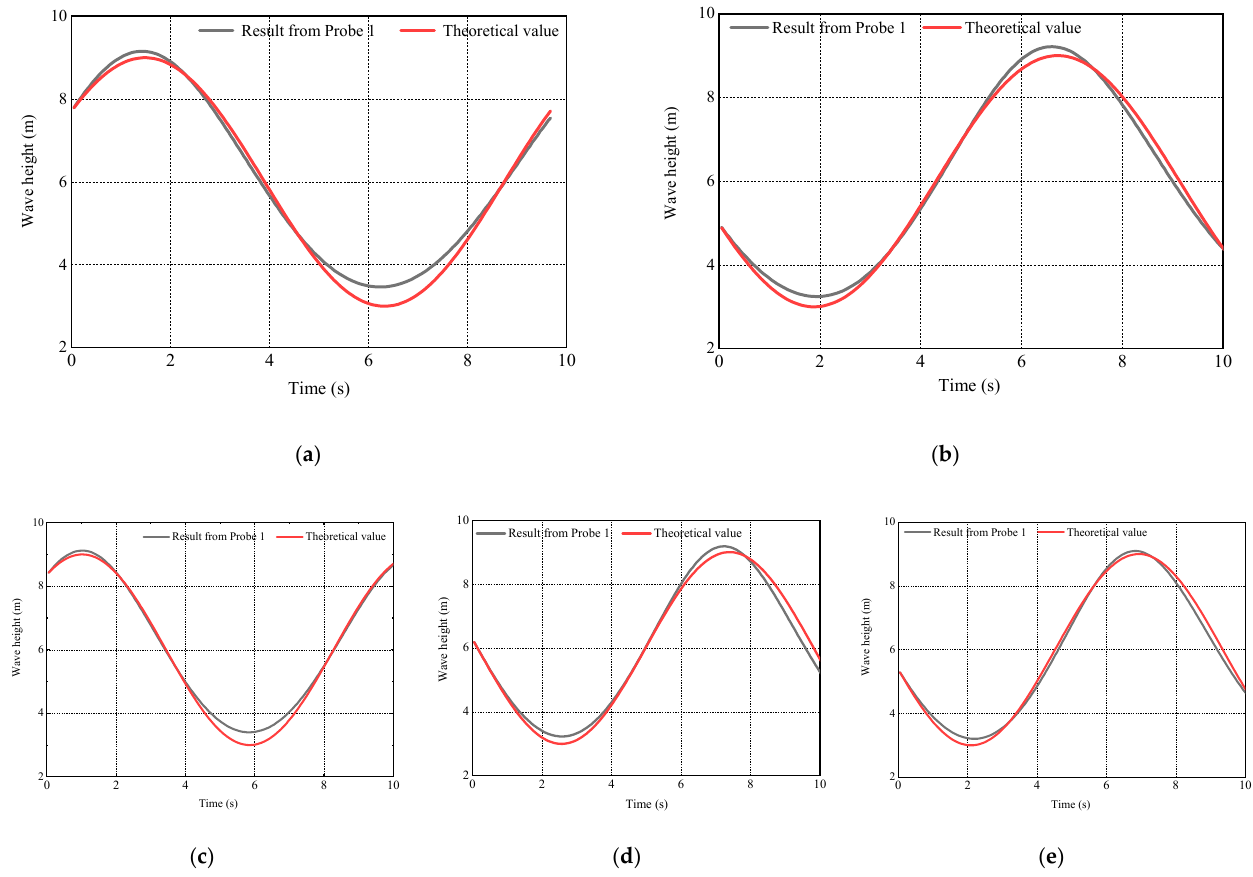
Figure 9. Wave elevation ( λ / L = 1.0). ( a ) θ = 0 ◦ ; ( b ) θ = 15 ◦ ; ( c ) θ = 30 ◦ ; ( d ) θ = 45 ◦ ; ( e ) θ = 135 ◦ . The initialized wave profiles with the trimaran model corresponding to the five different wave headings are obtained and shown in Figure 10. It can be seen that the wave shows an elliptical shape at the outlet boundary. This is because that wave damping is set at the outlet boundary to eliminate the reflected wave. Wave damping is used at the boundary of the flow field to damp and attenuate the waves near the selected boundary, so as to reduce the oscillation near the boundary. The damping introduces vertical resistance to the vertical motion. The waves generated by the hull can be damped and attenuated to avoid the reflection of waves at the boundary. Due to the different damping of peaks and troughs, irregular elliptical boundaries appear. Moreover, the setting of damping at the outlet has little effect on the wave near the hull and will not cause the attenuation of the wave near the hull. The maximum and minimum theoretical values of wave elevation are 3 m and 6 m. The error between the maximum value and theoretical value in the figure is caused by the size difference between the grid in the overset region and the background region, which may lead to a certain deformation of the wave surface near the interface. The maximum error, which is in the head wave, reaches 2% of the wave